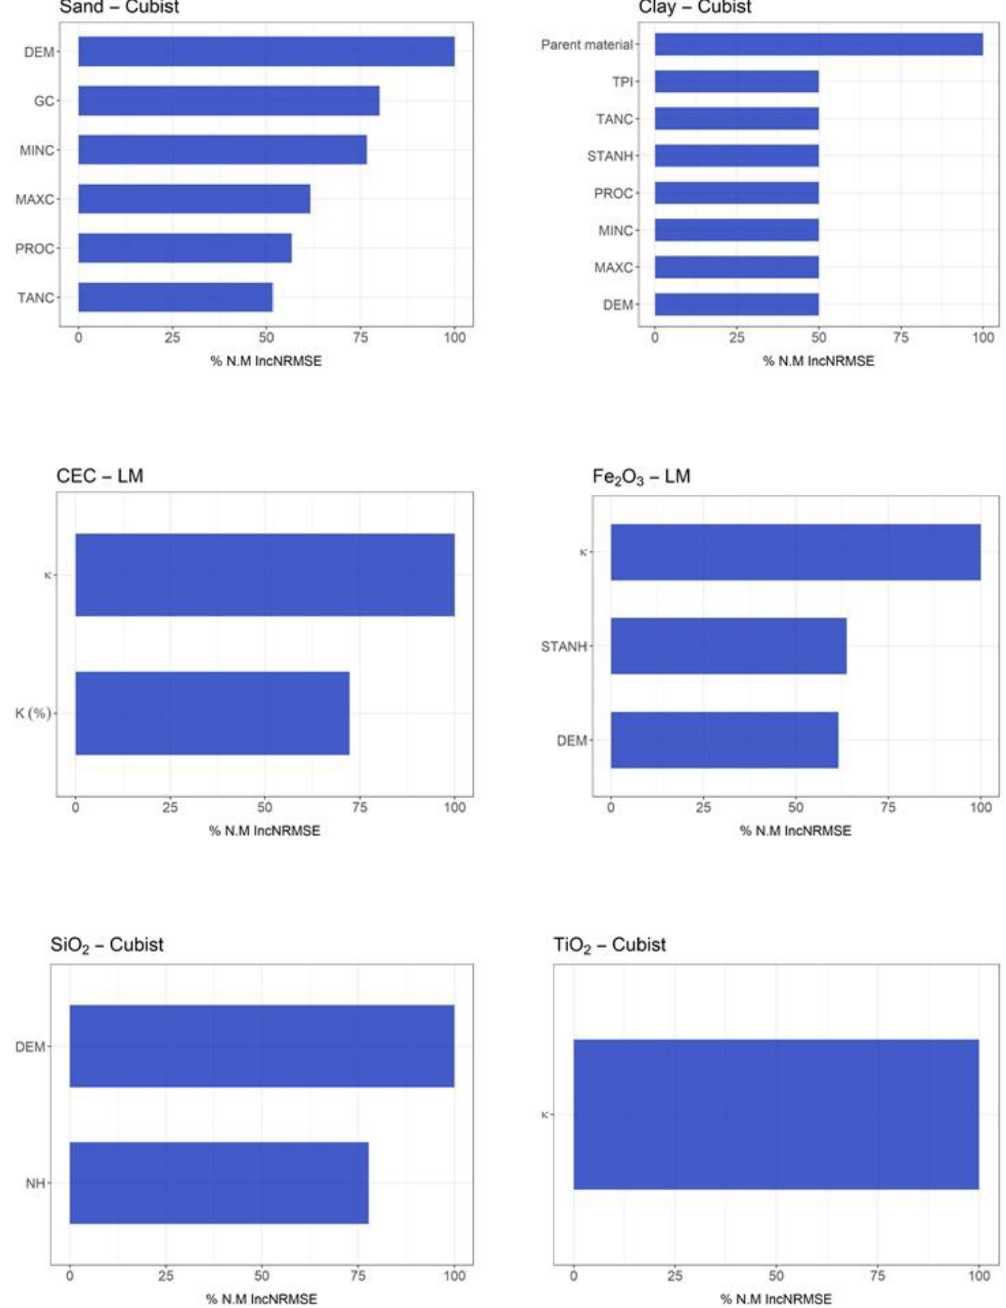
Figure 6. Variable importance for combined use of the three geophysical sensors (only variables that contributed more than 50% are pre- sented here; for further details see